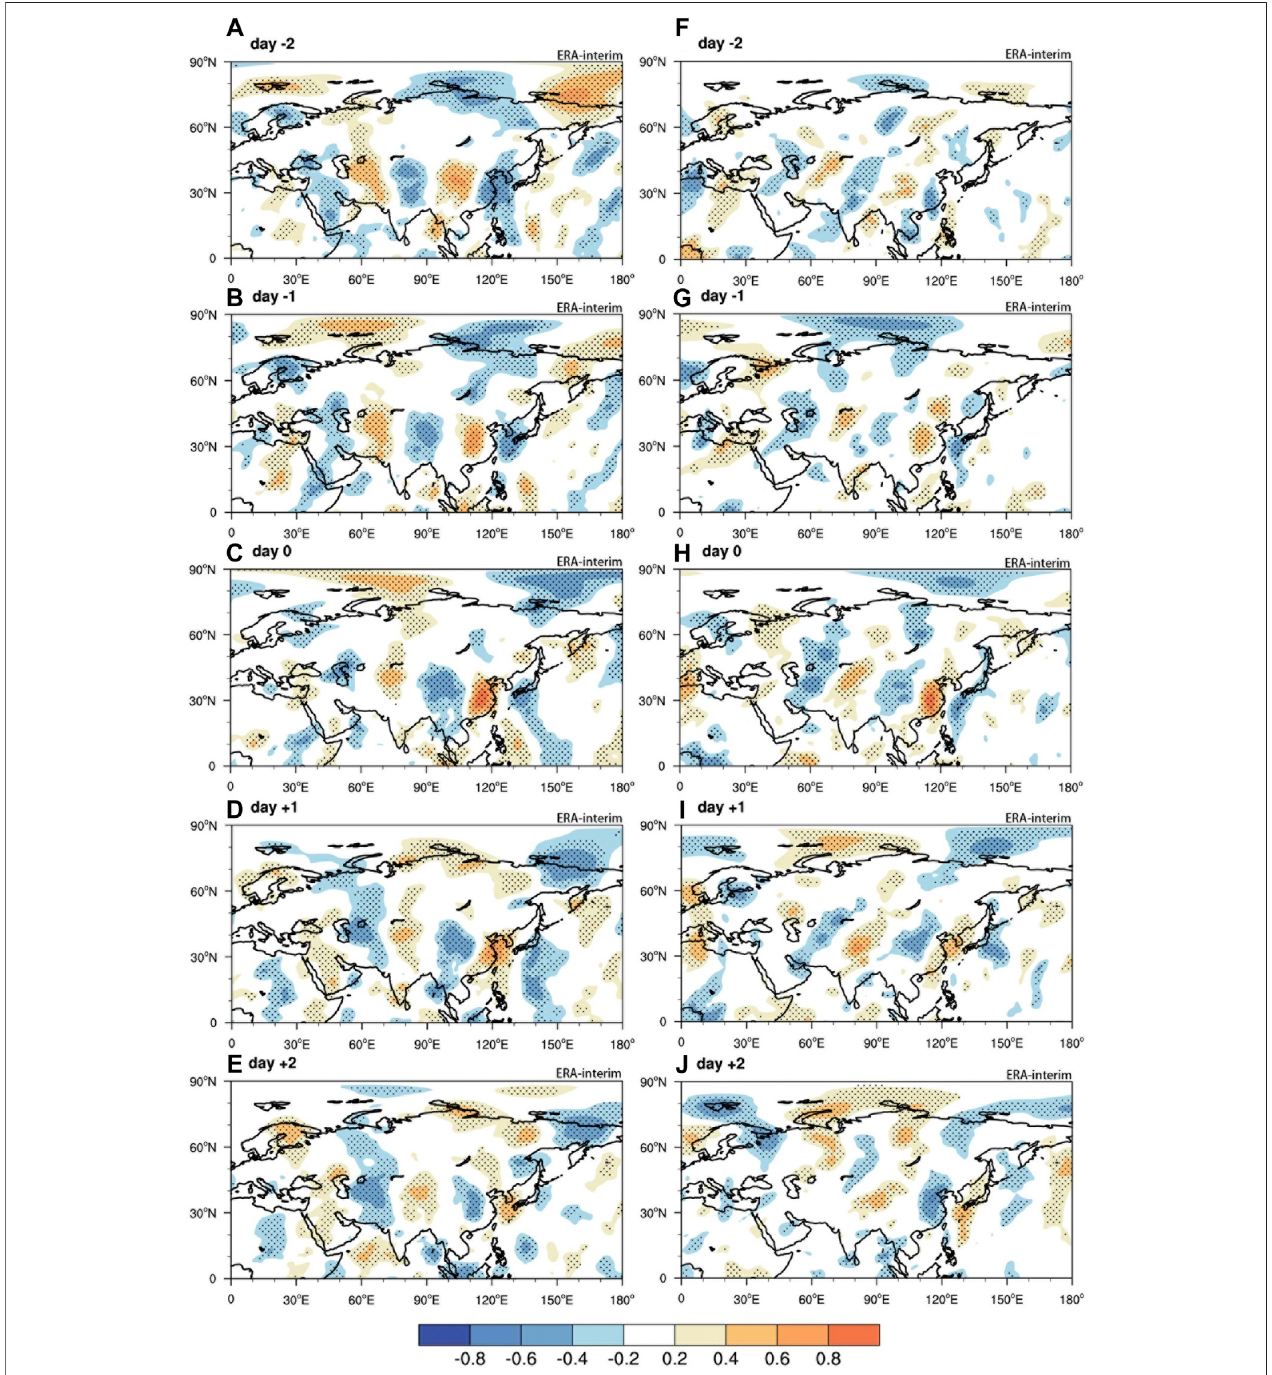
FIGURE 8 | One-point lag correlation of 300 hPa v ″ at the base point (30 ° N, 115 ° E) from day − 2 to day +2 during Meiyu periods in PHRE years (A – E) and non- PHRE years (F – J) . Areas with absolute values less than 0.2 are omitted. The dots show the areas with Monte Carlo (Ebisuzaki, 1996) signi fi cances exceeding the 95%